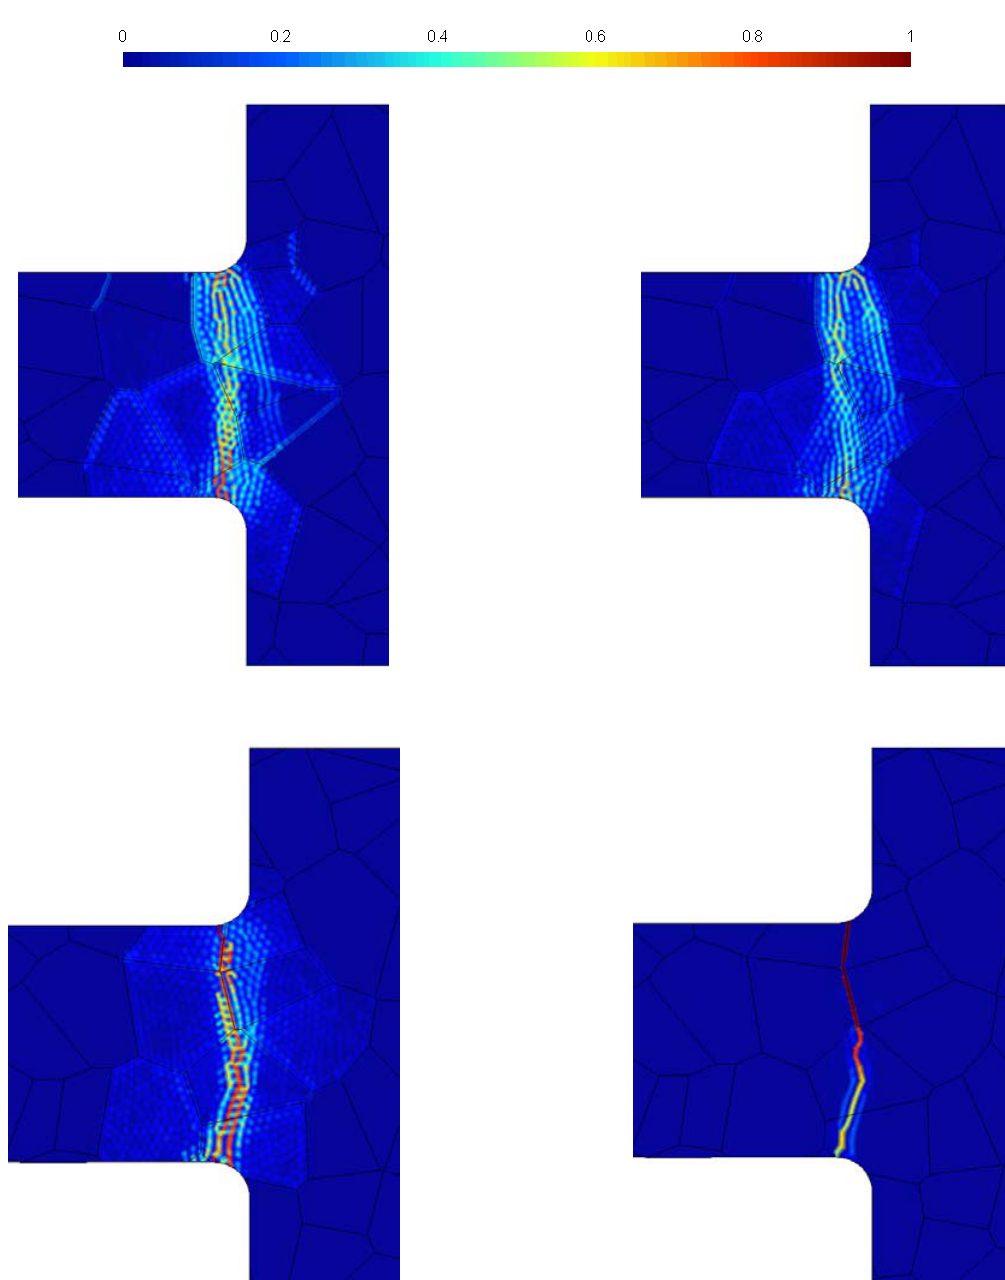
 M t GPa, 5.2  M t GPa); G GB  M t GPa, 0.2  M t G GB